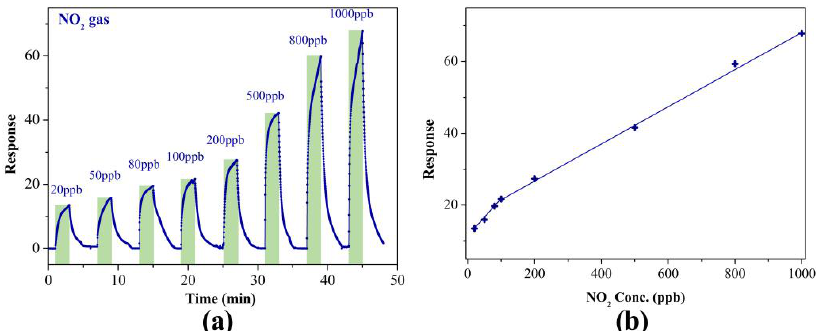
Figure 3. ( a ) Dynamic sensing performance of WN/WO 3 composites sensor to NO 2 with concentration from 20 to 1000 ppb at room temperature (RT); ( b ) calibration curves of WN/WO 3 composites sensor towards various concentrations of NO 2 at RT.